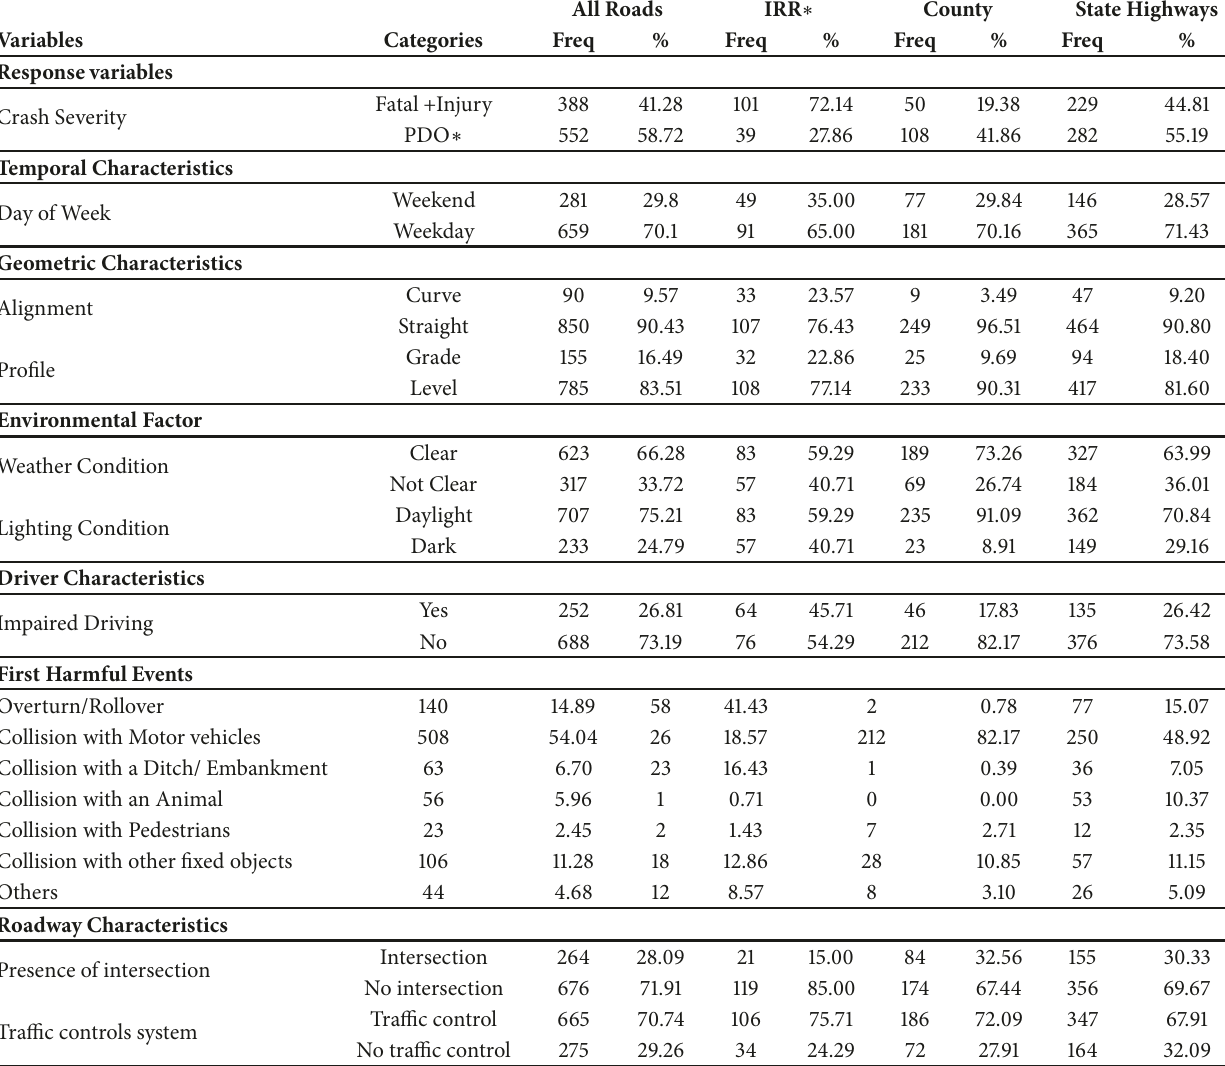
Table 1: Initial variables and their frequency and